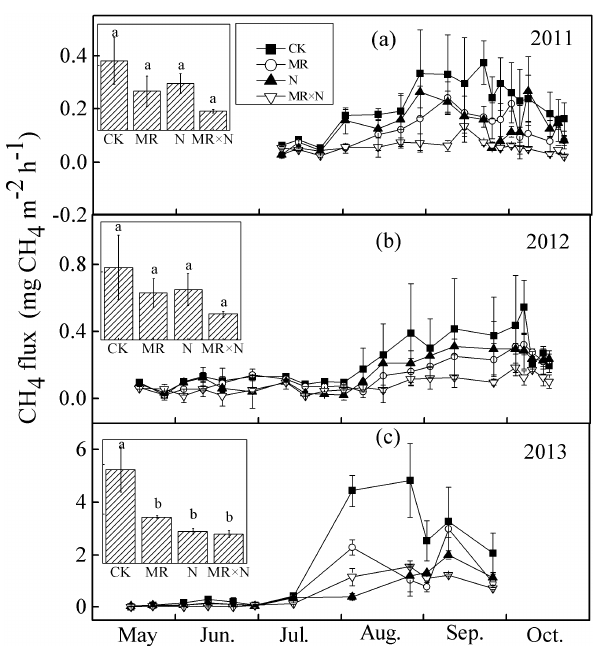
Figure 2. Temporal dynamics of CH 4 flux during the growing sea- sons in 2011, 2012 and 2013. Data are daily means ( ± SE, n = 3). Insets represent the seasonal means. CK, control; MR, moss re- moval; N, N addition; MR × N, moss removal plus N addition. Dif- ferent lowercase letters indicate significant differences among treat- ments ( p < 0 .